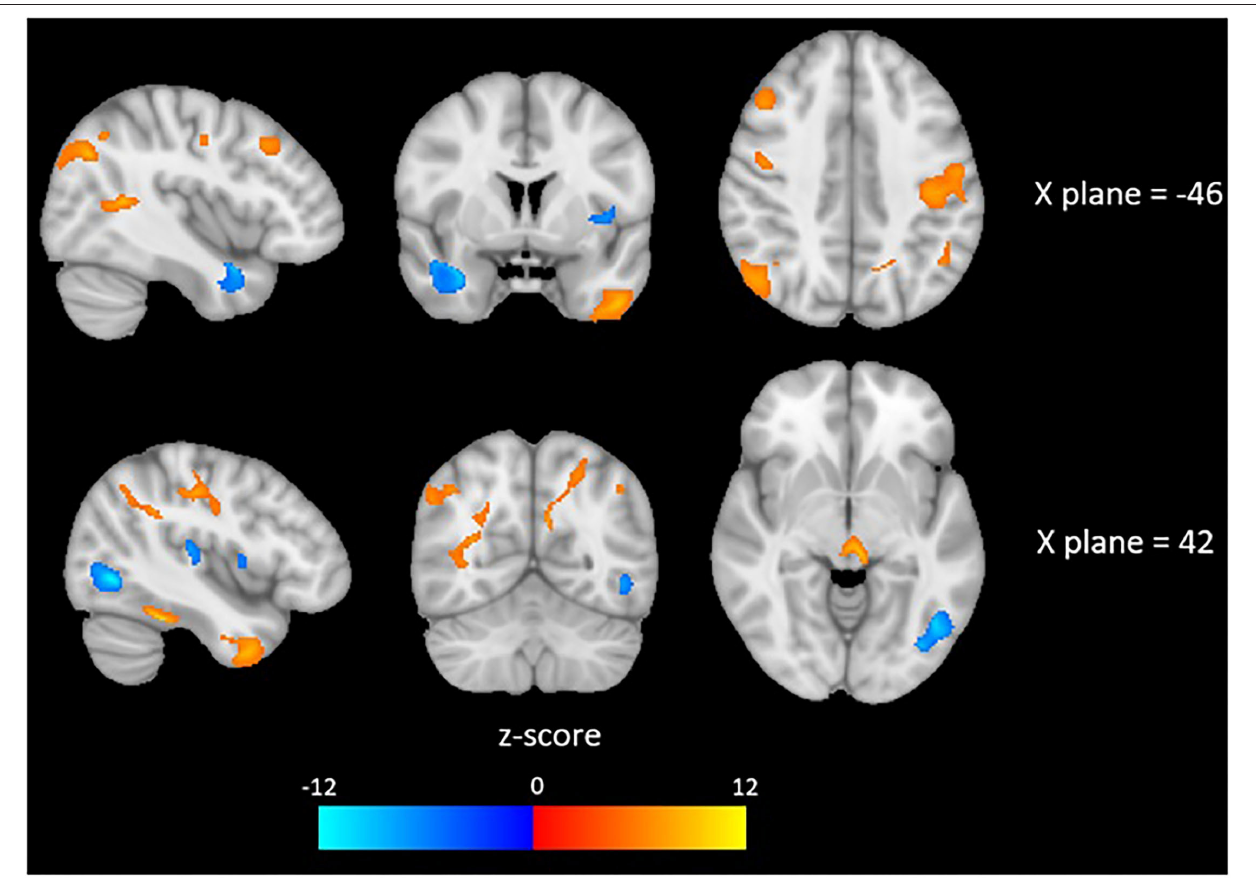
FIGURE 4 | Red colors indicate a positive association and blue colors indicate a negative association between depicted brain areas and impulsivity, as measured by the Two Choice Impulsivity Paradigm–Maximum Number of Consecutive Immediate Choices